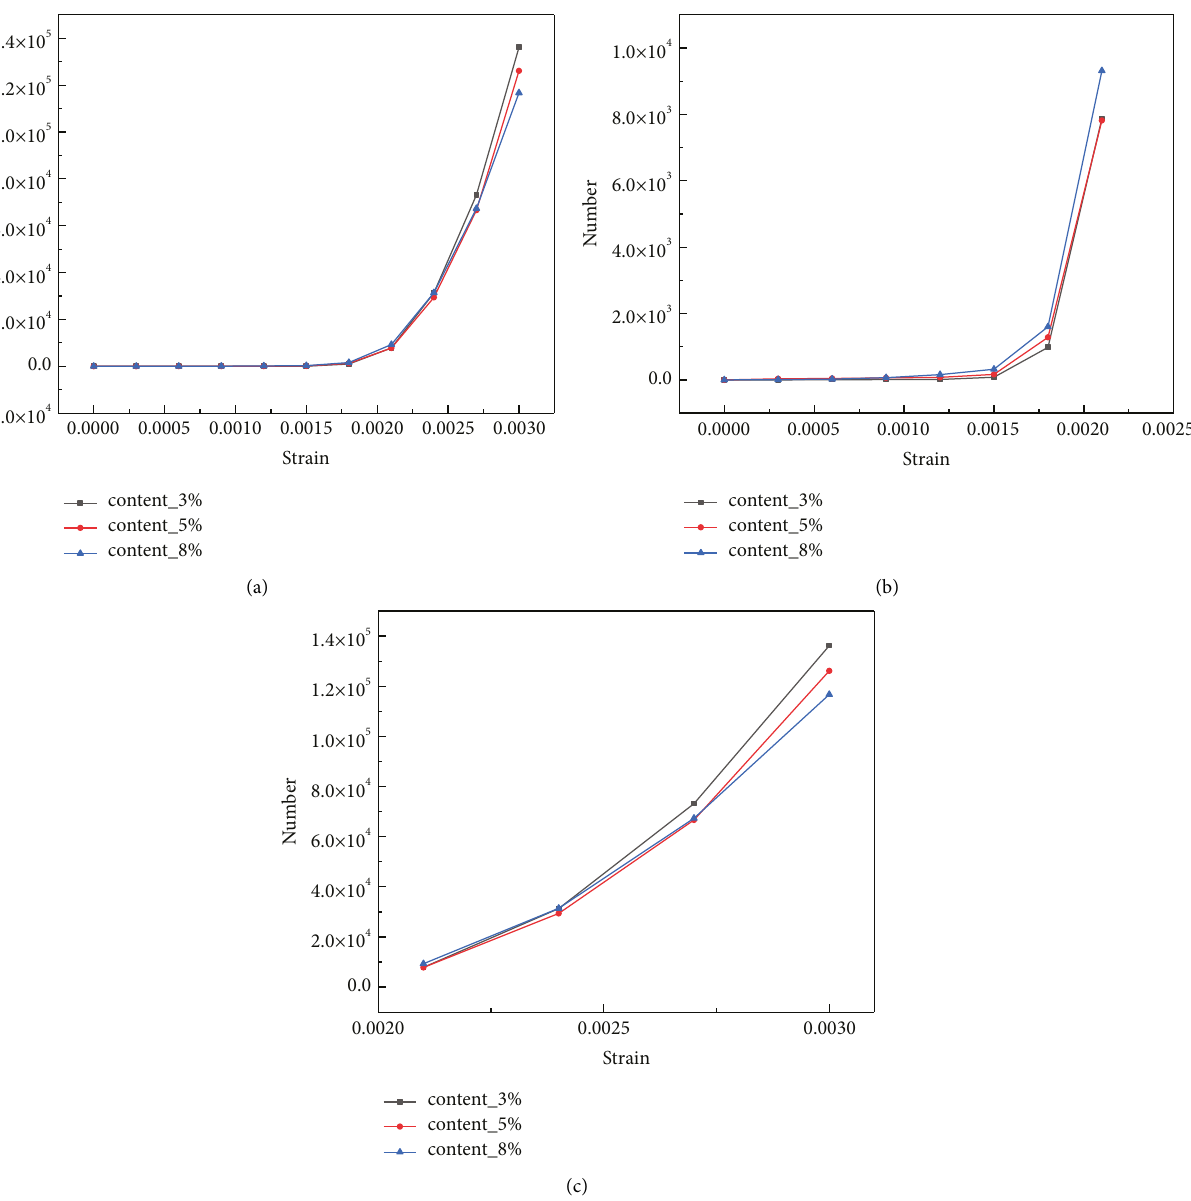
Figure 10: Number of mortar units with damage factor greater than 0.7 under different rubber content. (a) Overall stage, (b) rising stage, (c) falling